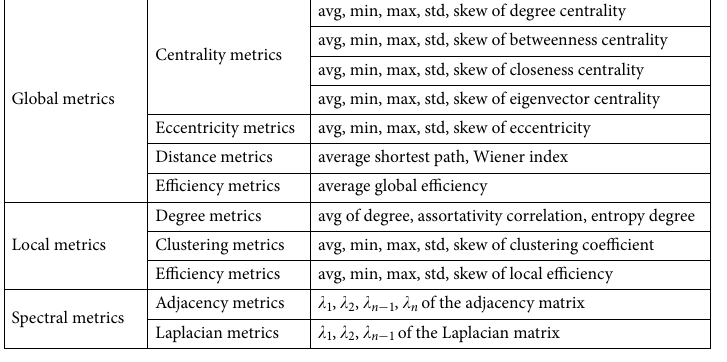
Table 1. Metrics